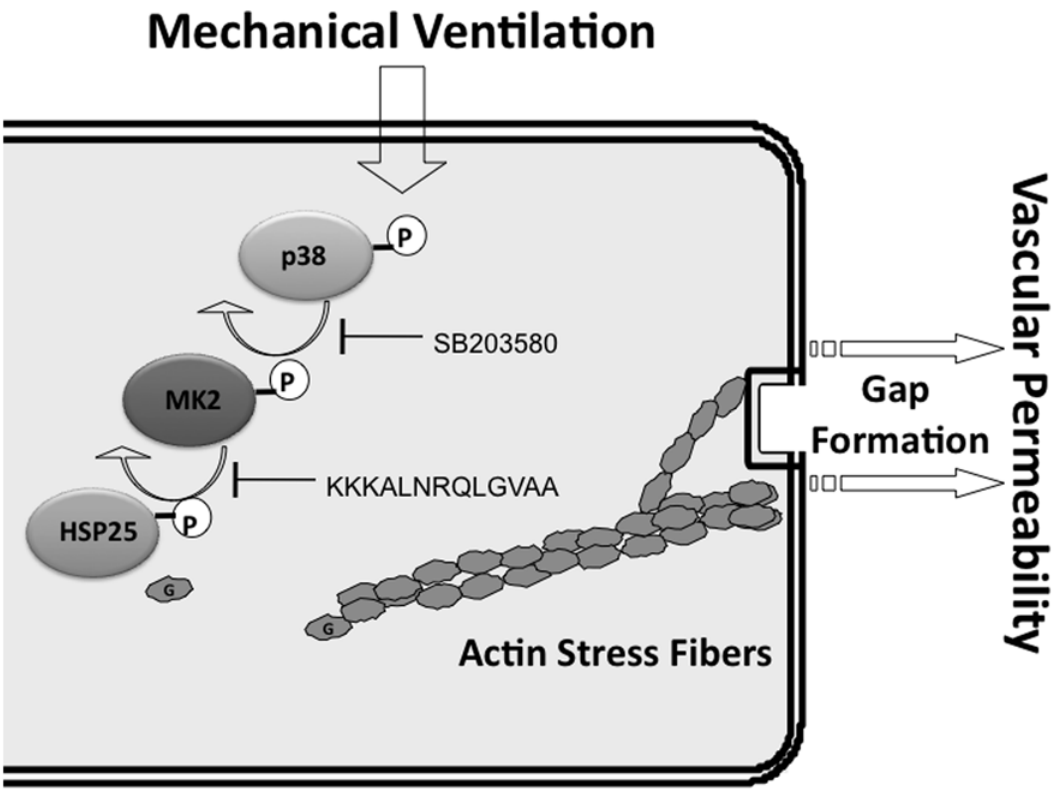
Figure 6. Schematic of p38 MAP kinase-MK2-HSP25 pathway. Activation of p38 MAP kinase by mechanical ventilation results in phosphorylation of MK2 and HSP25 leading to disassociation of monomeric actin from HSP25 and actin stress fiber formation mediated